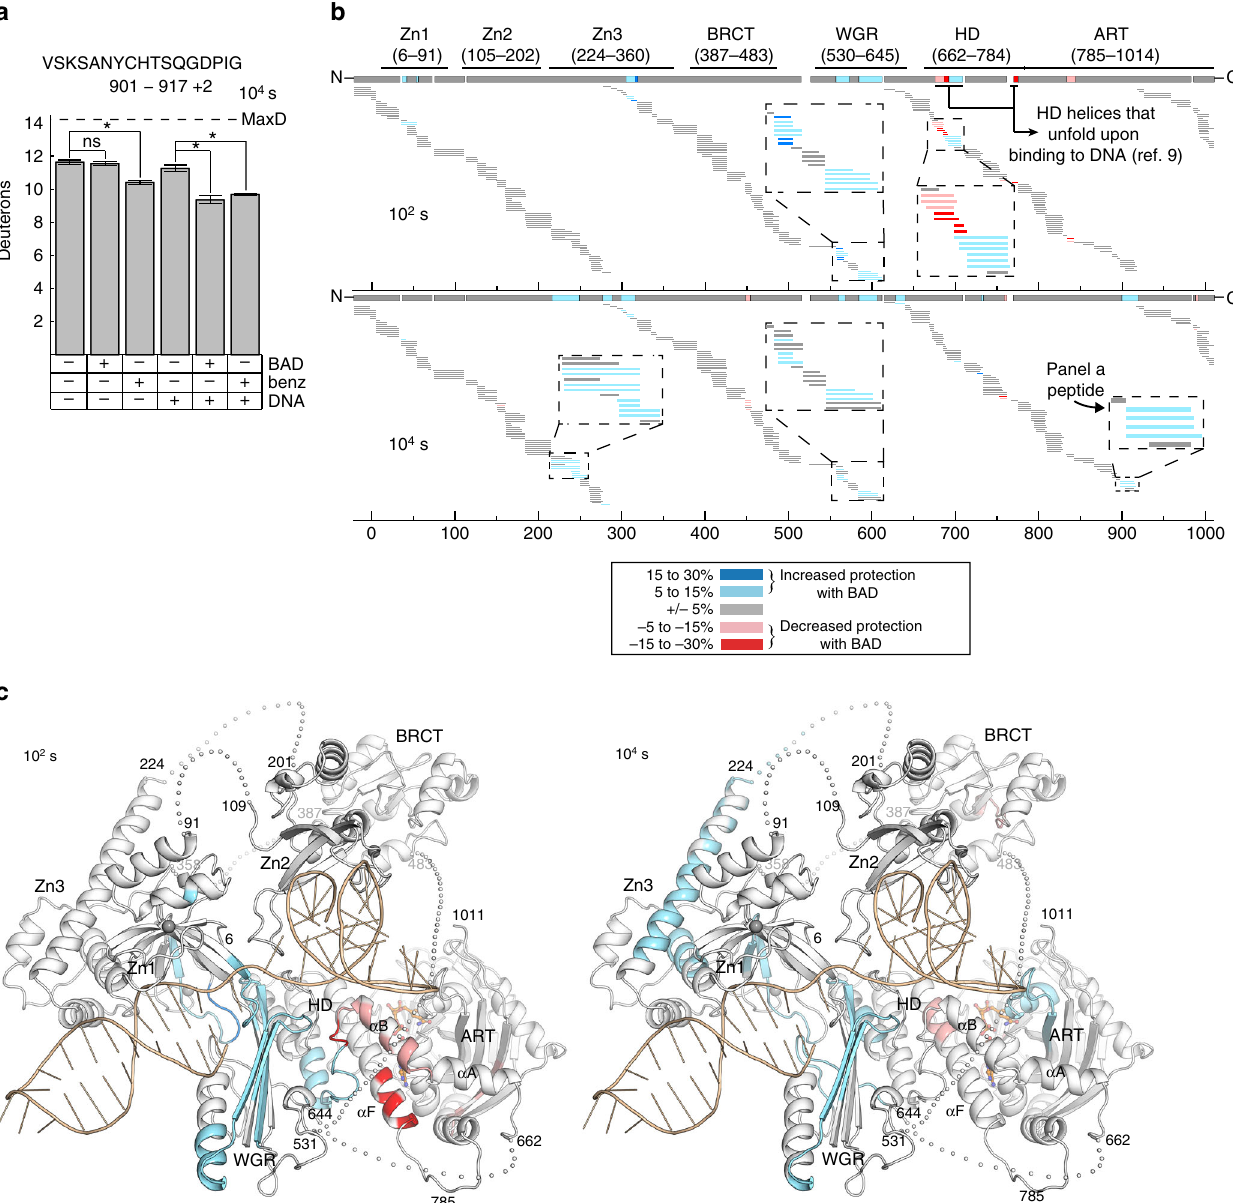
Fig. 5 HXMS analysis of NAD + analog-dependent changes in PARP-1 dynamics. a Level of deuteration at 10 4 s of a peptide from NAD + binding site (a.a. 901 – 917, charge state + 2) in the absence or presence of DNA (dumbbell DNA containing a central 1 nt-gap) and in the absence or presence of either BAD or benzamide. Errors were calculated as a standard deviation from three independent measurements. Maximum possible deuteration for the given peptide is shown by dashed line (MaxD). An asterisk denotes signi fi cant differences (*, P < 0.0005), with others marked as not signi fi cant (n.s.). b Percent difference in deuteration for each peptide, represented with horizontal bars, was calculated between DNA-bound PARP-1 samples in the absence and presence of BAD at 10 2 s (top panel) and 10 4 s (bottom panel) time points. Peptides that exhibit increased protection from deuteration upon BAD binding are shown in blue colors, whereas the ones with decreased protection from deuteration upon BAD binding are in red, as shown in the insert of the top panel. Each peptide color indicates the average percent difference in deuteration for the whole peptide, therefore there are some overlapping peptides where one exhibits difference in deuteration pattern, whereas the other one does not. The consensus behavior at each PARP-1 residue is displayed in the horizontal bar below the PARP-1 domain annotation. Gaps in protein coverage are indicated with white spaces. When available, data for multiple peptide charge states are presented. c The consensus for the HXMS data from panel b at 10 2 s and 10 4 s has been plotted on the combined crystallographic and NMR structure of PARP-1 in complex with a DNA single-strand break 6 – 8 . The linker residues (each shown as an individual sphere) and the BRCT